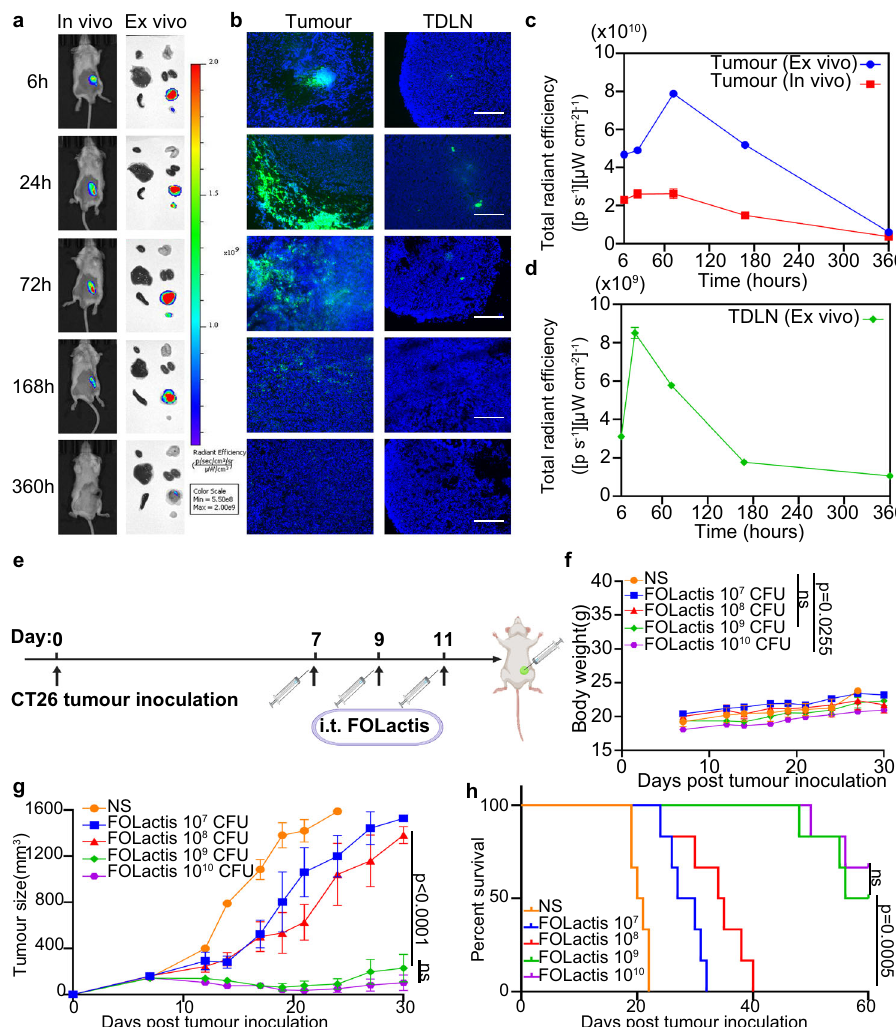
Fig. 3 | Temporal colonization and biodistribution of FOLactis. a Left, Repre- sentative in vivo near-infrared imaging of tumor-bearing mice at 6, 24, 72, 168, 360h after intratumoural injection of 10 9 CFU FOLactis ( n =3). Right, Representa- tive ex vivo imagesof the hearts, livers, spleens,lungs, kidneys, tumors and TDLNs collectedat 6, 24, 72,168, 360h afterinjection ( n =3). b Frozen sections of tumors and TDLNs in CT26 mouse colon tumor model at 6, 24, 72, 168, 360h after intra- tumoural injection of 10 9 CFU FOLactis ( n =3). FOLactis were labeled with DiO (green); nucleus, blue. White scale bars, 200 μ m. c Total radiant ef fi ciency of FOLactis signal in tumors in vivo or ex vivo over time ( n =3, biologically indepen- dent samples). The error bars represented mean ± s.e.m. d Total radiant ef fi ciency of FOLactis signal in TDLNs ex vivo over time ( n =3, biologically independent samples). The error bars represented mean ± s.e.m. e Schematic diagram of the treatment in male CT26 tumor-bearing mice. BALB/c mice were implanted with CT26 cells (5×10 5 ) on the left lower sides of the abdomen on day 0, and received